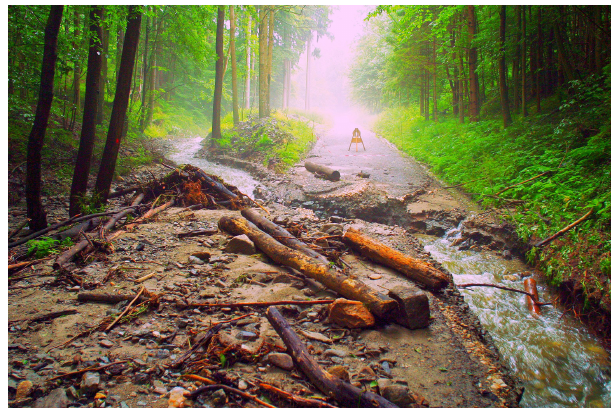
Figure 2. Destructions of forest roads due to a storm on 29 June 2009 (Photo: Josef